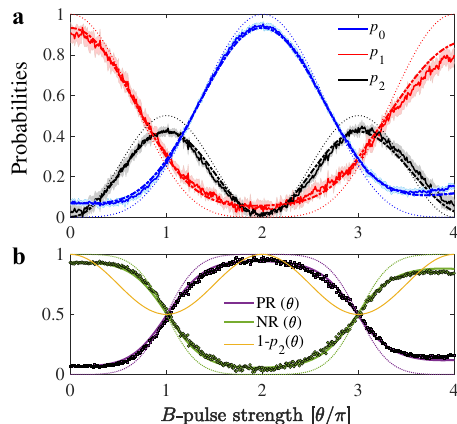
Fig. 2 | Probabilities and associated positive/negative ratios for N =1. a Probabilities vs. strength for a single B -pulse in our three-level system. The experimentally averaged pro fi les for the ground state ( p 0 ), fi rst excited state ( p 1 ) and second excited states ( p 2 ) are represented by blue, red and black colored continuous lines respectively. The corresponding colored dot-dashed lines are the simulated curves including decoherence and pulse imperfections, while the thin dotted lines show the ideal case. Each experimental curve is accompanied by a shaded region presenting the standard deviation of the mean obtained from 16 replicas of the same experiment. b Corresponding to each B -pulse strength, PR( θ )= p 0 ( θ )/[ p 0 ( θ )+ p 1 ( θ )] and NR( θ )= p 1 ( θ )/[ p 0 ( θ )+ p 1 ( θ )] obtained from the experiment are shown with purple circular markers and green square markers respectively, closely followed by the simulated purple and green continuous curves. The thin dotted lines represent the respective ideal cases, with no deco- herenceandwithoutanyexperimentalimperfections.Thecontinuousyellowcurve stands for the norm of the system subspace: p 0 ( θ )+ p 1 ( θ )=1 − p 2 ( θ